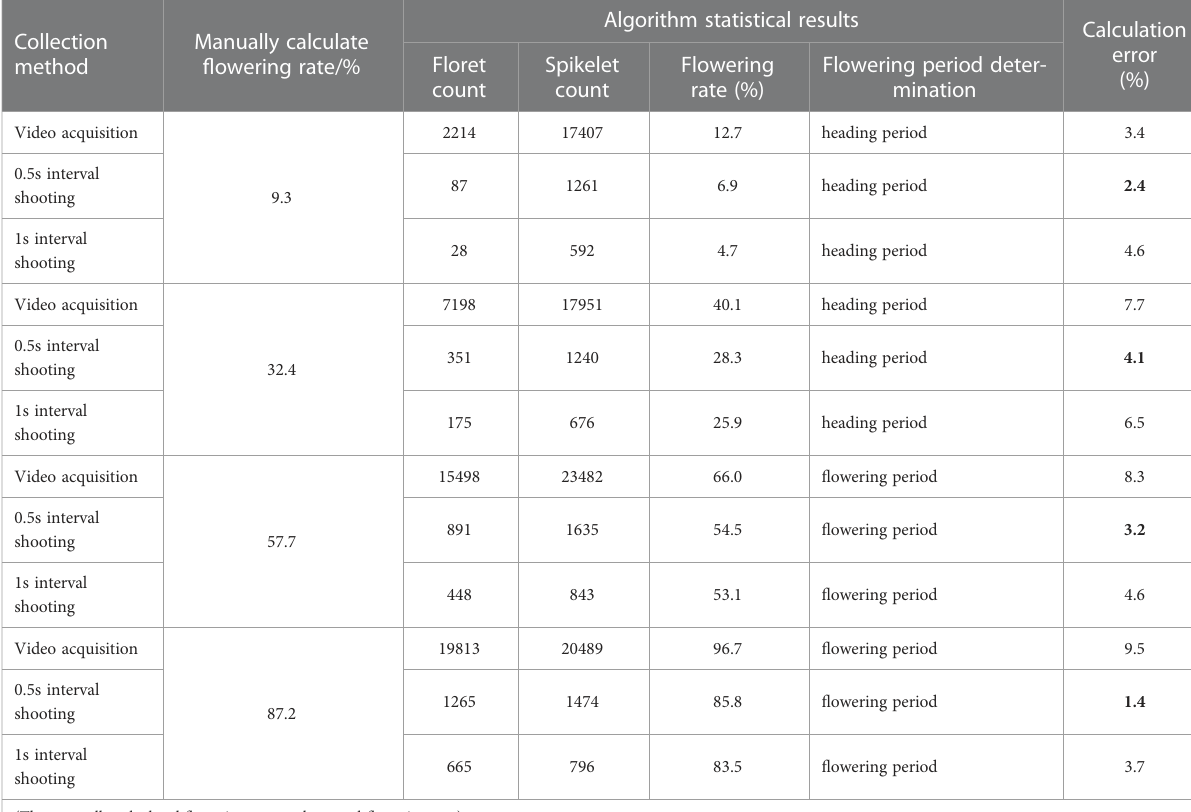
TABLE 7 The fl owering period determination under different collection